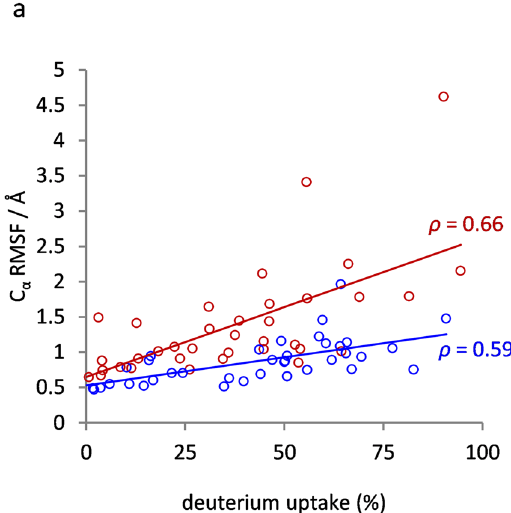
Figure 4. Comparison of simulation C α -RMSF values with hydrogen/deuterium-exchange data. Amino acid specific C α -RMSF values (from Fig. 2a) averaged for the residues in each of the peptides analyzed in the HDX experiment as well as relative deuterium uptake after 1 minute exposure to D 2 O of active and latent PAI-1 are plotted for active and latent PAI-1 in Figure S6. In the present figure the correlation between C α -RMSF values and relative deuterium uptake for active (red) and latent (blue) peptides (taken from Figure S6) is investigated by plotting the two data sets on each axis. Trendlines and Pearson correlation coefficients ρ are shown.